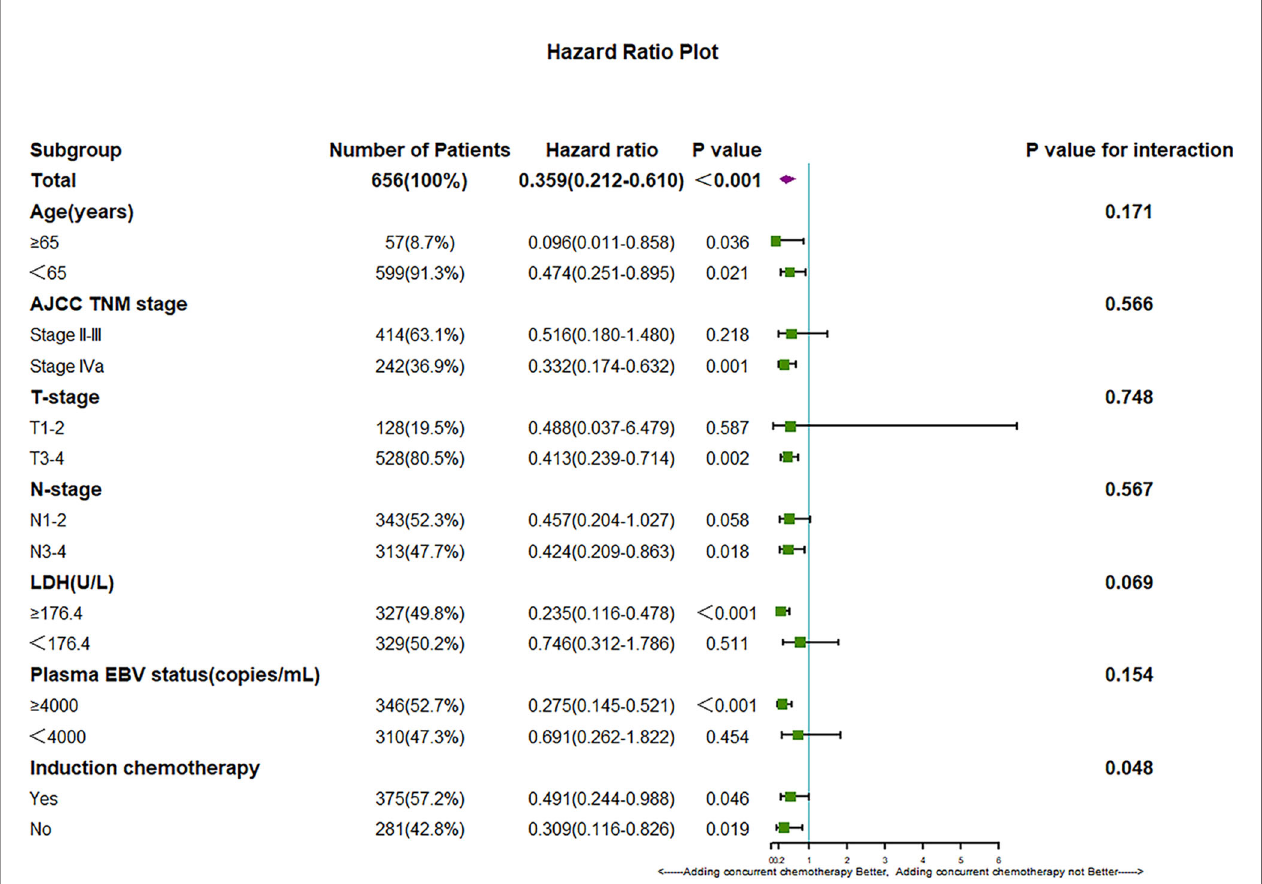
FIGURE 3 | Hazard ratios for death and the interaction of the addition of CDDP with age, tumor stage, LDH, plasma EBV DNA copies and IC